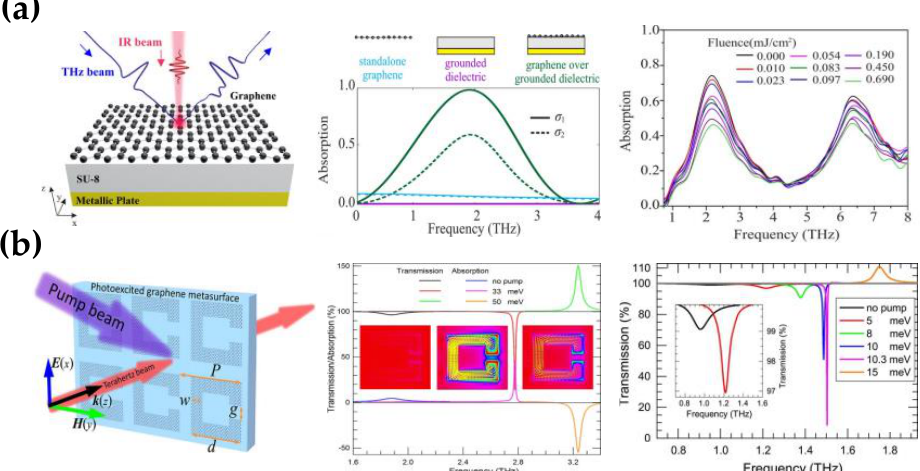
Figure 4. Optically pumped terahertz amplitude modulator based on graphene. ( a ) The metasurface is composed of graphene deposited on SU-8 substrates, the absorption spectra of three structures for perfect absorption conditions graphene conductivity ( 𝜎 1 ) and for another case ( 𝜎 2 ) that does not fulfill above conditions, the photoexcited spectra of a graphene-based structure under fluence from 0 to 0.690 mJ/cm 2 ; (Reprinted with permission from ref. [51] Copyright 2019, American Chemical Society) ( b ) The periodic array of split-ring resonators made of photoinduced monolayer graphene, the magnetic resonances of graphene SRRs under optical pumping, transmission spectra for unpumped and pumped graphene with different Fermi levels. (Reprinted with permission from ref. [65] Copyright 2018, American Chemical